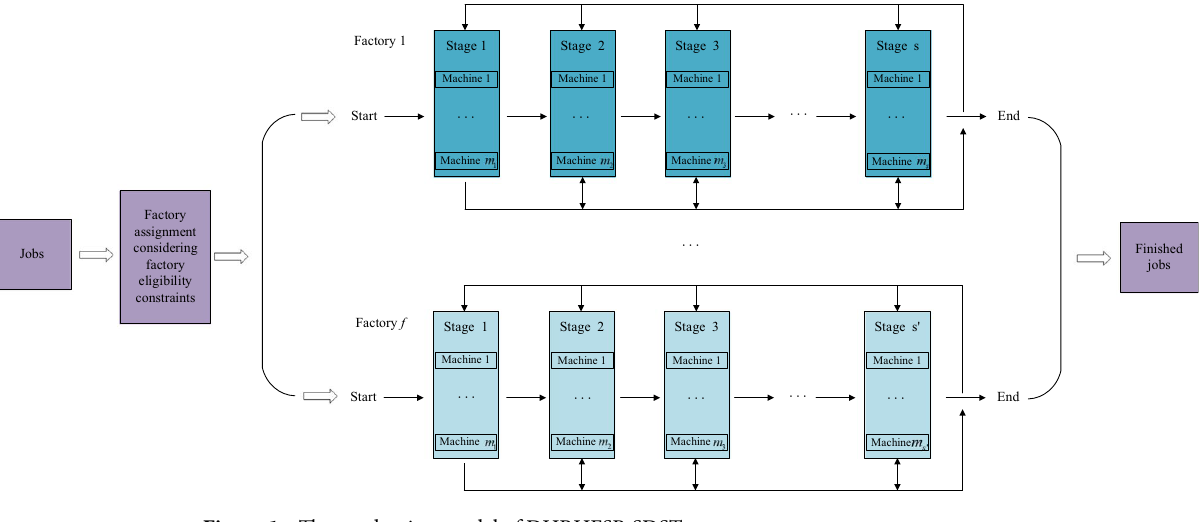
Figure 1. The production model of